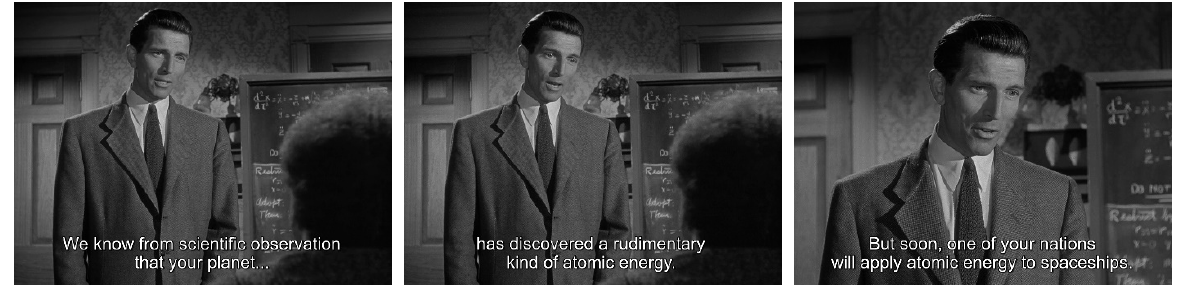
Figure 1. Klaatu’s ‘atomic energy’ comments. The Day the Earth Stood Still © 20th Century Fox. All Rights Reserved.